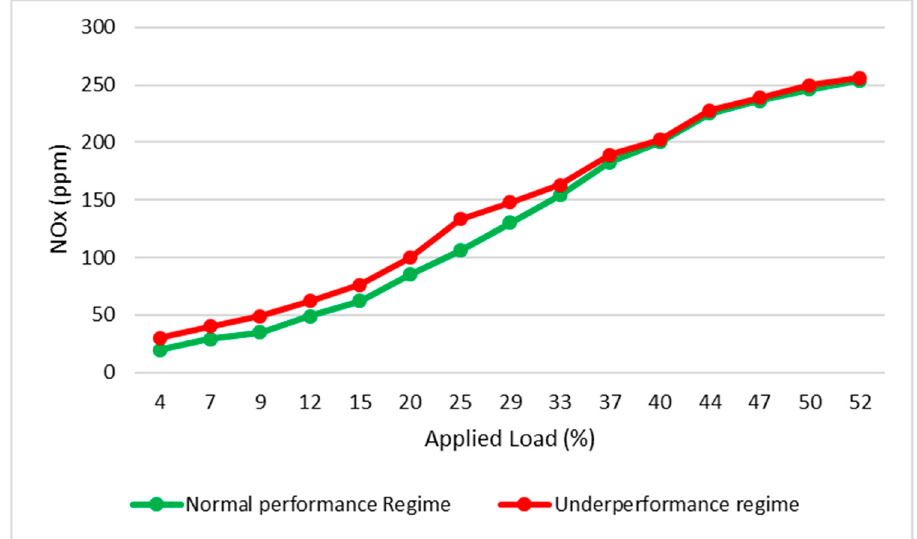
Figure 11. Variation of the NO x content in the exhaust gas according to the applied loads.